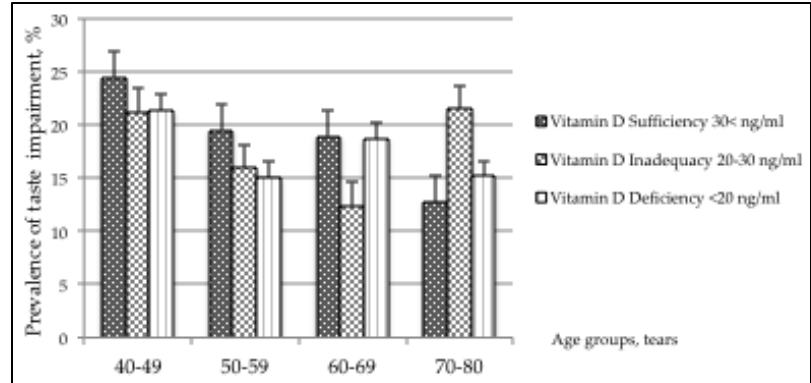
Figure 2. Prevalence of taste impairment across age groups by levels of Vitamin D.